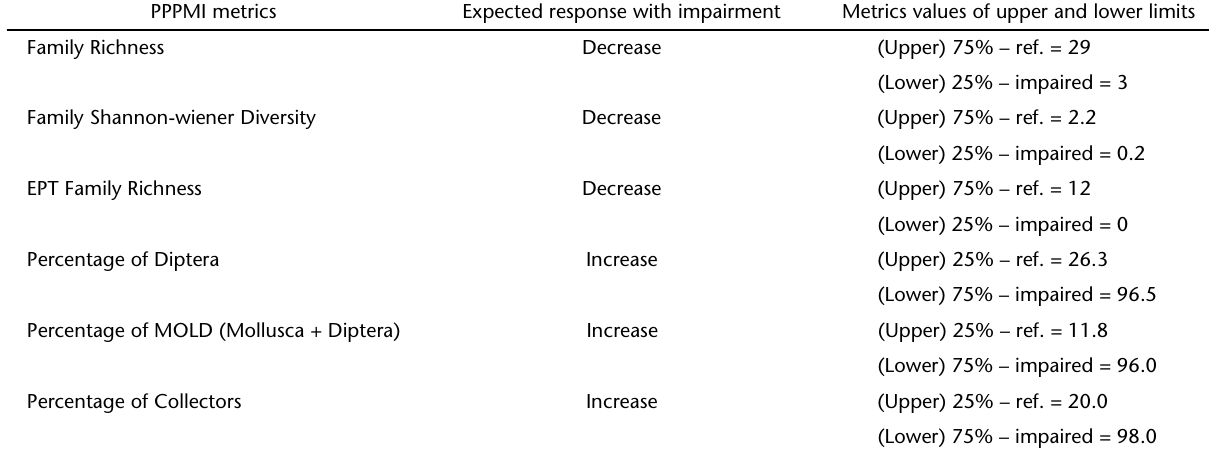
Table III. Expected responses with increased impairment and metric value thresholds for the six metrics selected to integrate the Piabanha- Paquequer-Preto Multimetric Index. PPPMI